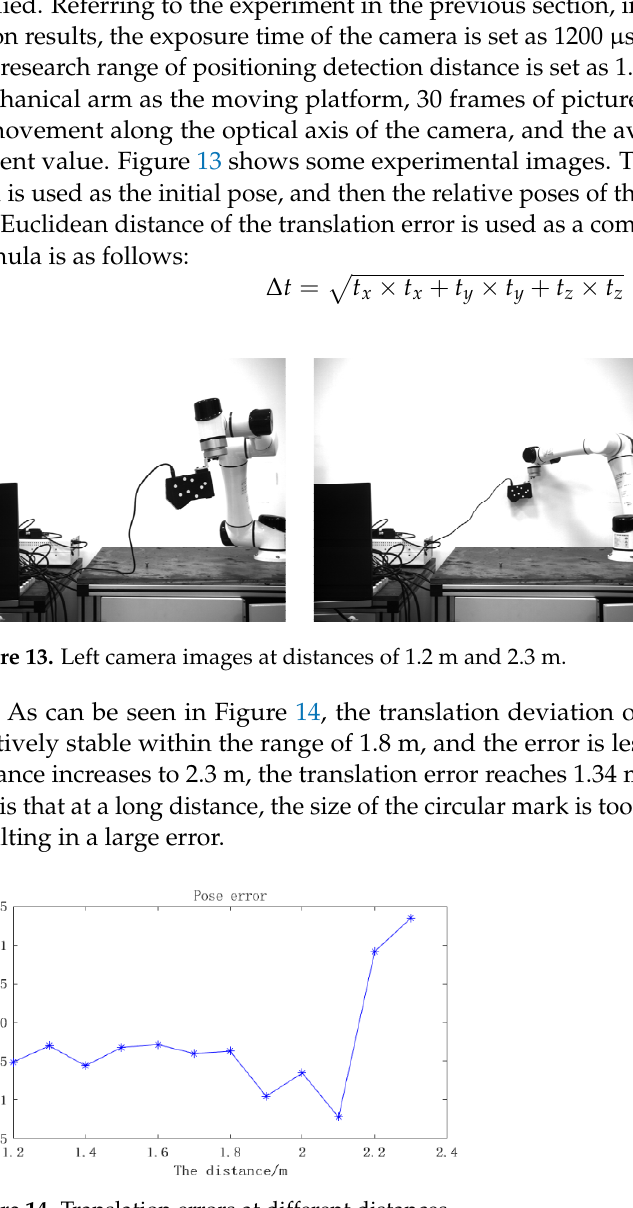
Figure 12. Positioning errors under different brightness conditions. ( a ) Rotational errors on the x, y, and z axes. ( b ) Translation errors on the x, y, and z axes.